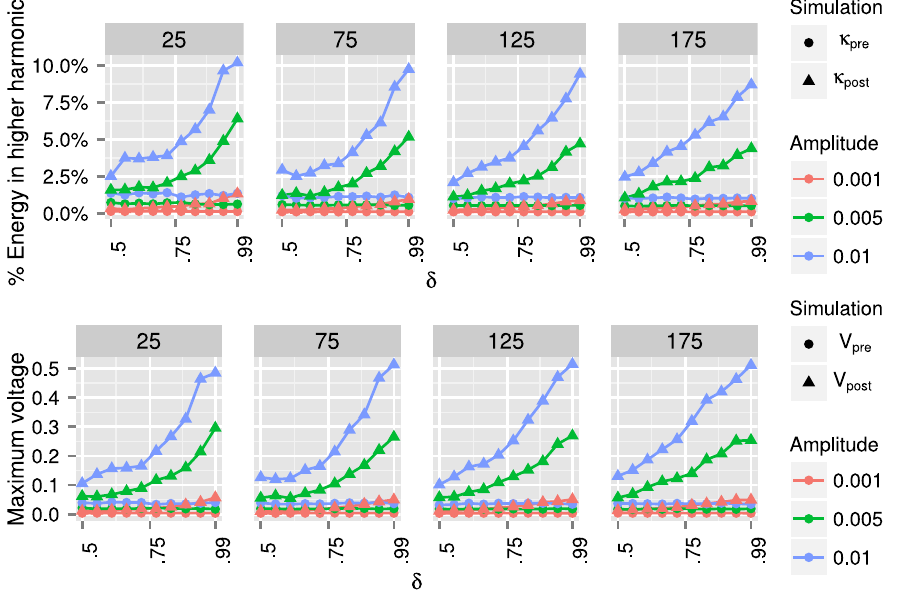
Figure 9. Watts-Strogatz random graph results. From left to right, we present results for Watts-Strogatz random graphs with N ~ 25 , 75 , 125 , and 175 nodes. For each graph, we use algorithm (36) to modify the inductances L such that the ratio of the smallest to the second smallest eigenvalue is d . We use pre and post to denote, respectively, the graphs before and after algorithm (36) is applied. By shrinking the gap between the first two eigenvalues, the energy transferred to higher harmonics (37) can be increased from k pre & 1 % to k post § 8 : 75 % (for all graph sizes), and the maximum voltage (38) can be increased from V pre & 0 : 05 volts to V post & 0 : 5 volts (for all graph sizes). The values of k post for Watts-Strogatz graphs are about twice as large as the values of k post for Baraba´si-Albert graphs in Figure 8.